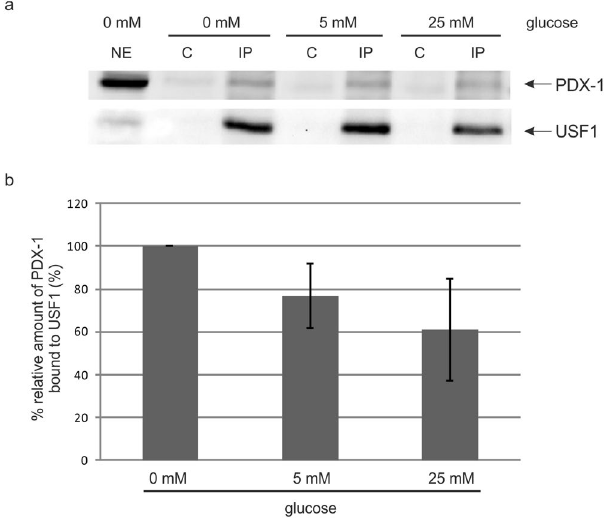
Figure 2. Co-immunoprecipitation of PDX-1 and USF1. ( a ) INS-1 cells were seeded on a 14.5 cm culture plate and starved overnight. The next day, cells were treated with 0 mM, 5 mM or 25 mM glucose and after a period of 4 h cytoplasmic and nuclear proteins were extracted as described in material and methods. Two mg nuclear extract were incubated with the USF1 specific antibody sc-8983 for 2 h, immunocomplexes were loaded on a 10% SDS polyacrylamide gel and transferred onto a PVDF membrane. PDX-1 was identified with the polyclonal rabbit antiserum against recombinant full-length mouse PDX-1, detection of USF1 with the USF1 specific antibody sc-8983 served as a control for immunoprecipitation. NE: 50 μ g nuclear extract; C: control precipitate; IP: immunoprecipitate. ( b ) Relative protein amounts of bound PDX-1 to USF1 were shown in the bar graphs. The diagram shows the mean ± SD of three independent experiments. The relative intensities of bound PDX-1 protein to USF1 were normalized to the protein content of precipitated USF1. Full-length blots are presented in Supplementary Figure